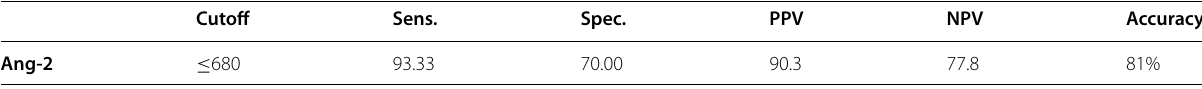
Table 11 Best cut off for pretreatment Angiopoietin-2 in predicting fibrosis